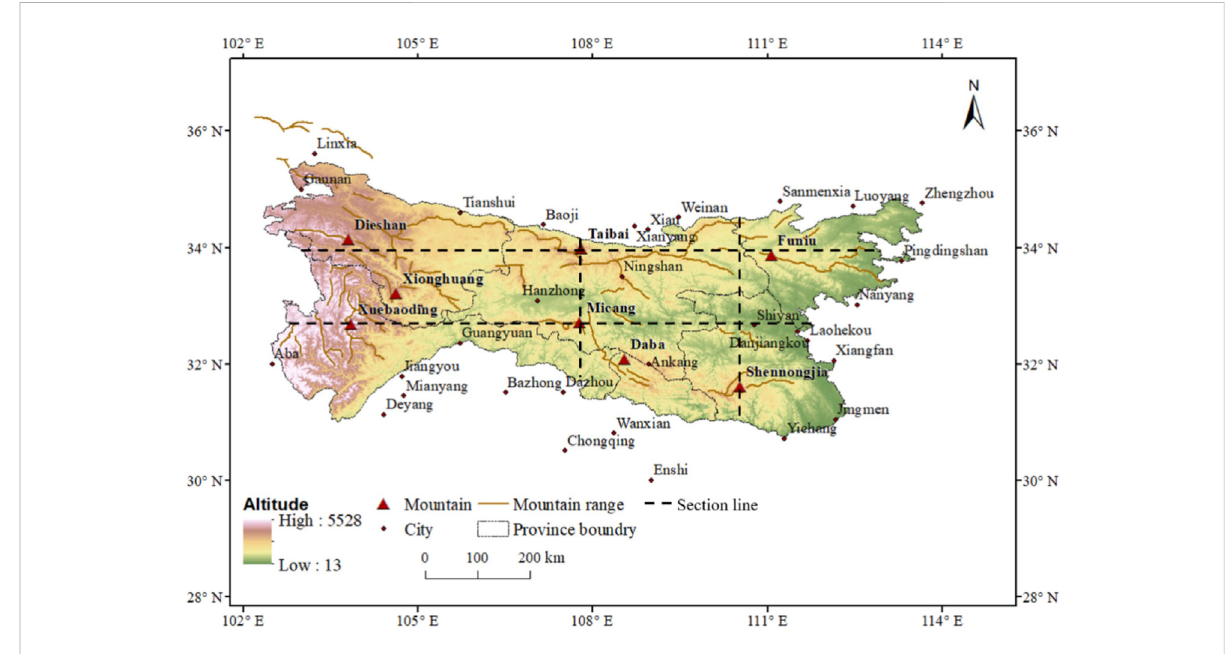
FIGURE 1 Topography of Qinling-Daba Mountains and the position of four section lines.